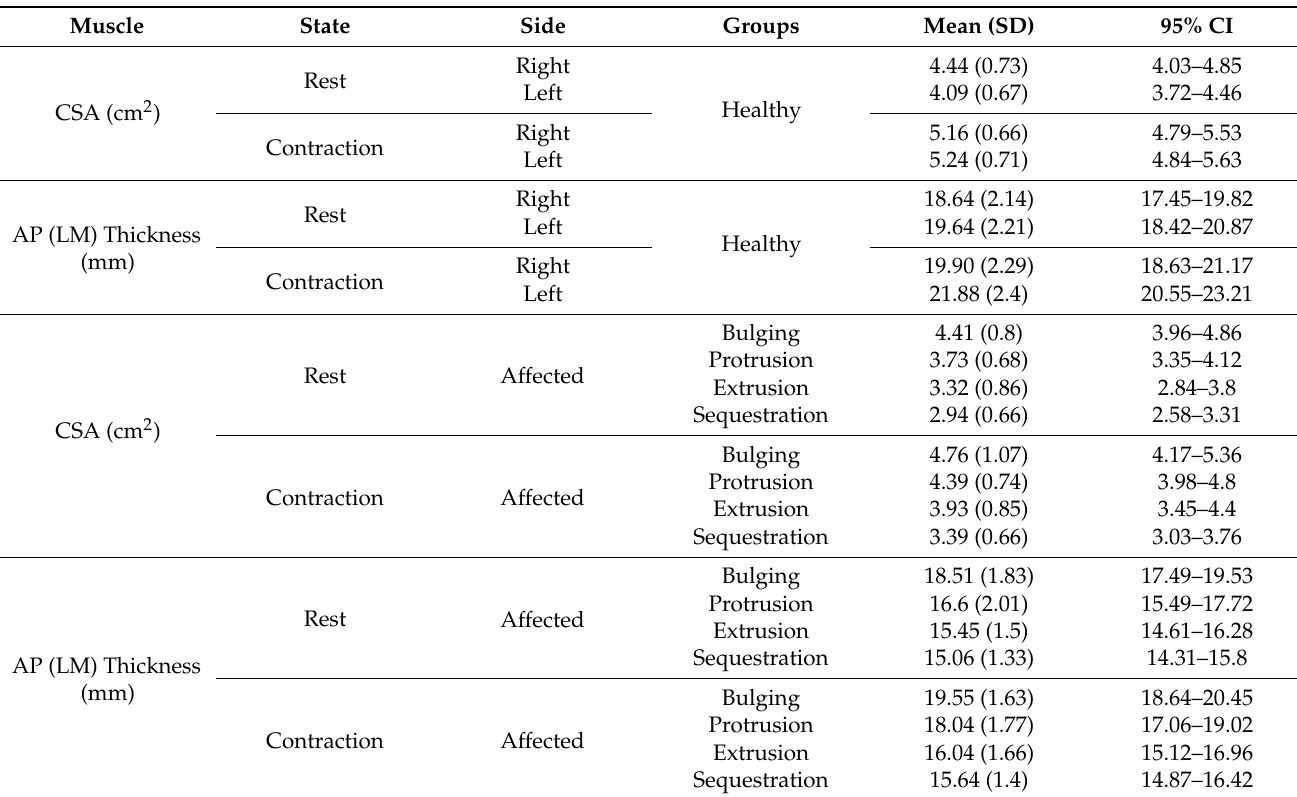
Table 2. LM muscle CSA and thickness measurements in LDH patients and healthy groups (at